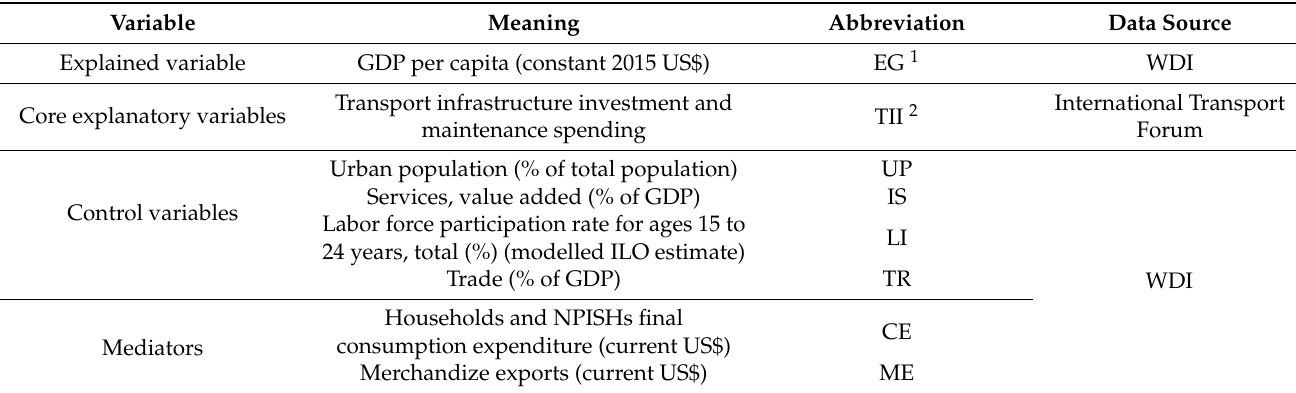
Table 2. Sources of variables.